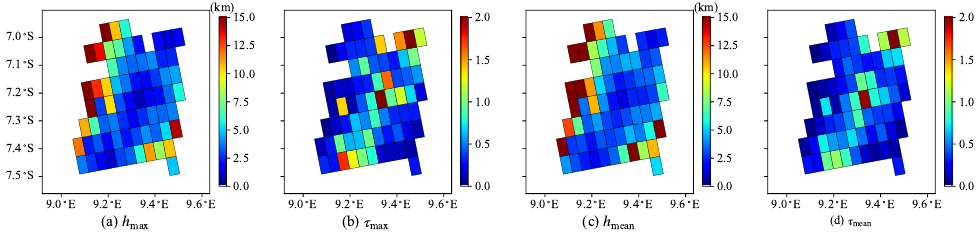
Figure 18. The same as in Figure 16 but for the data on 5 July